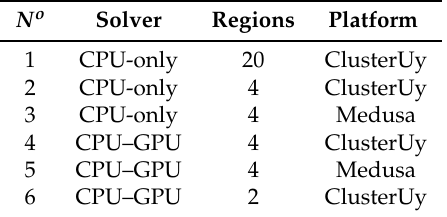
Table 1. Simulations run for each solver with their configurations and platforms.